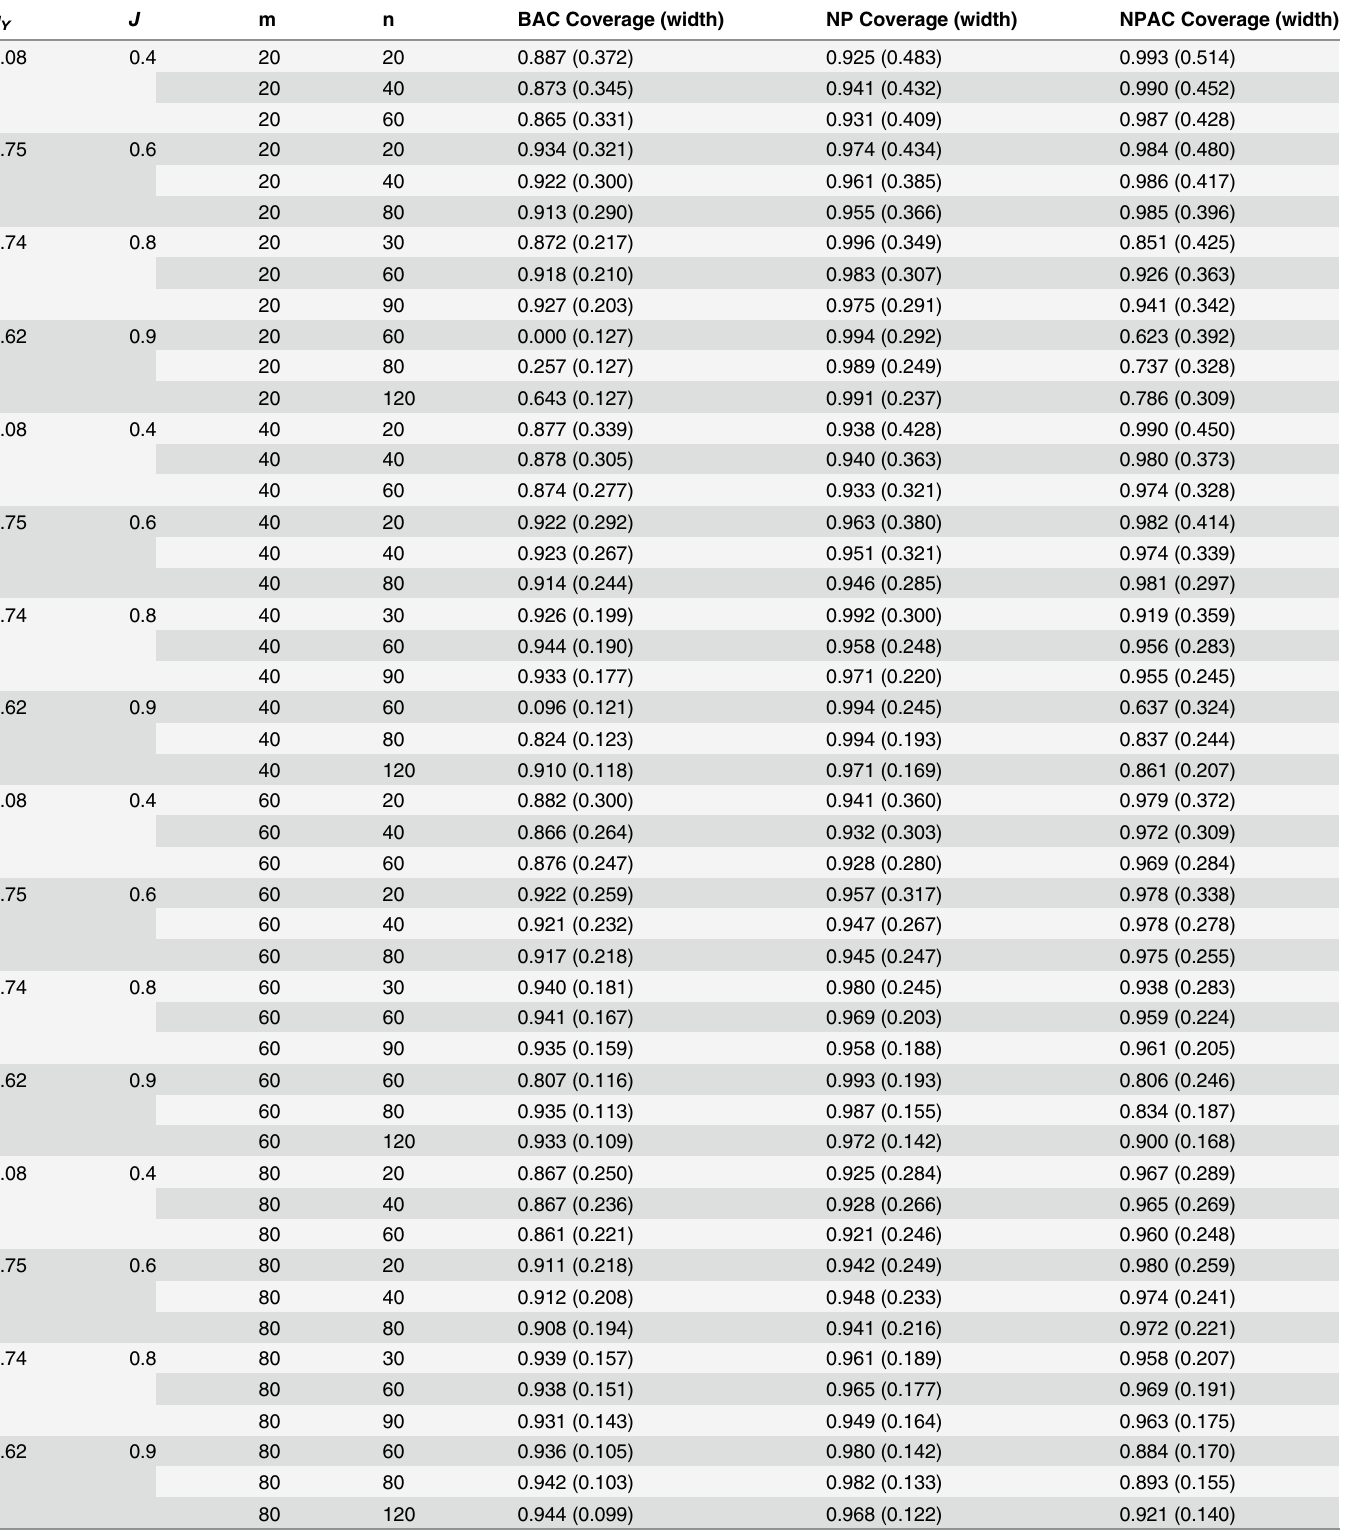
Table 9. Mixed distribution (t distribution and normal distribution): coverage probabilities and average widths at the 95% nominal